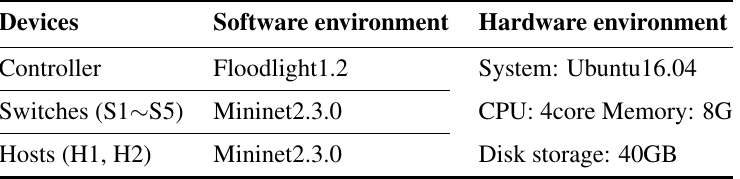
Table 4 Experimental